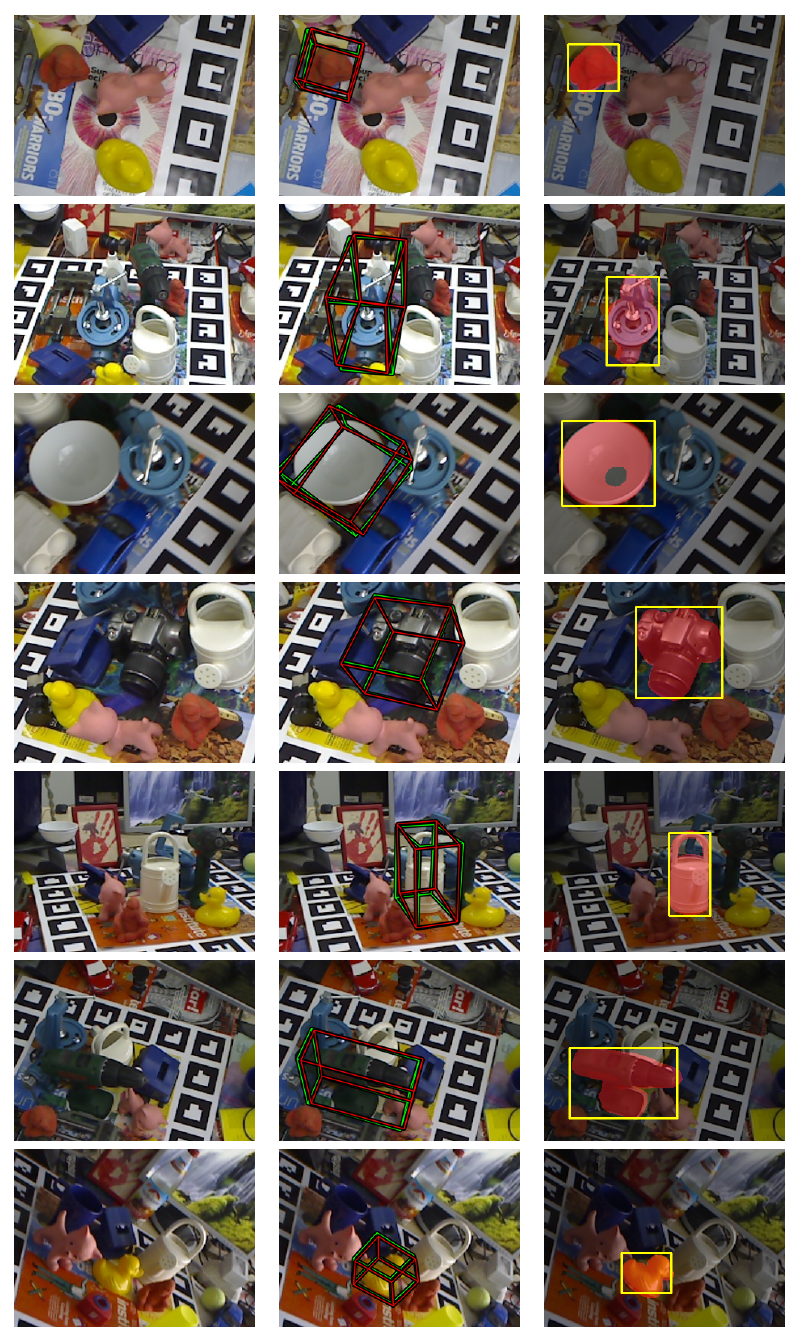
Figure 7. Results visualisation of the estimated pose using the LINEMOD dataset. The bounding box projection of the actual pose is shown in red, and the estimated pose by our method is shown in green (best viewed in